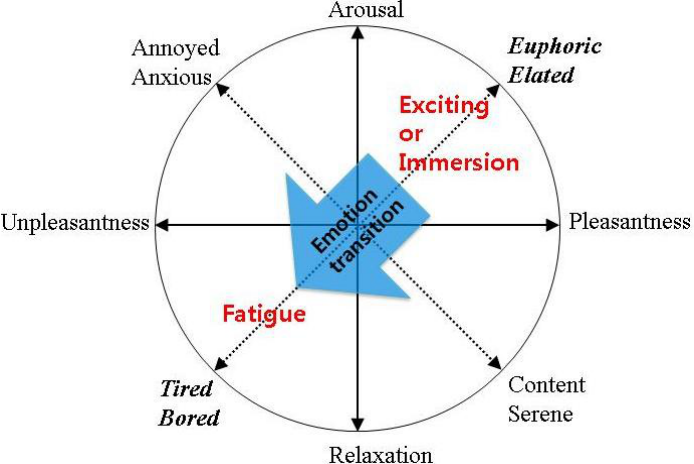
Figure 8. Emotion transition from immersive or exciting to